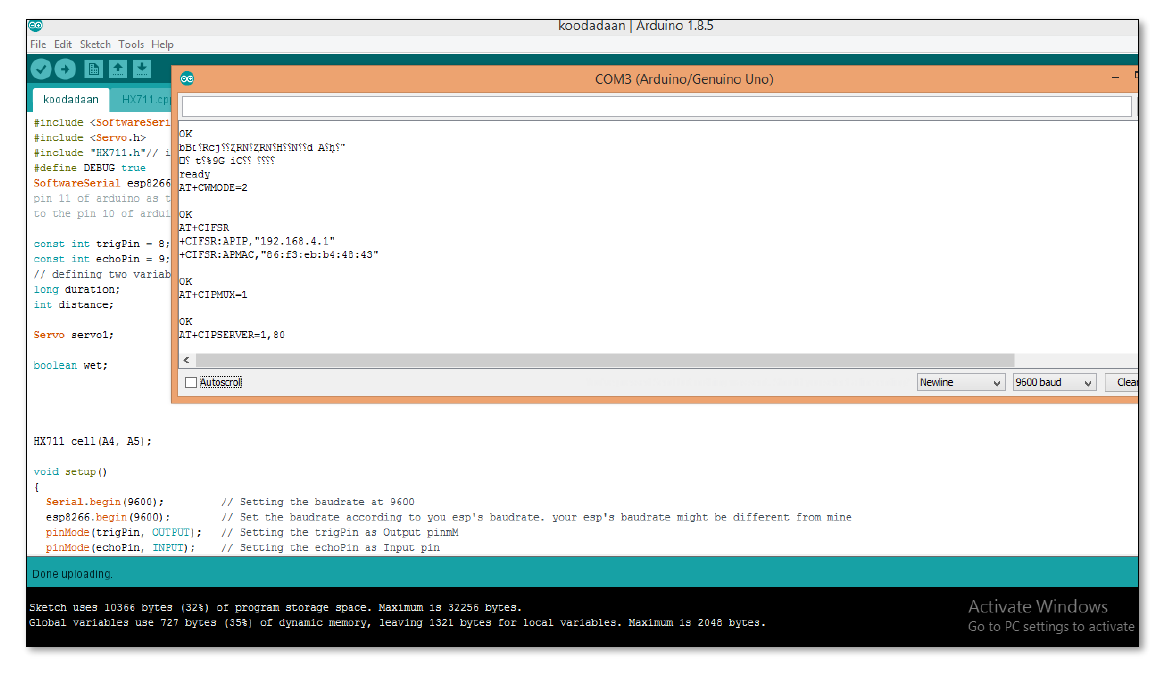
Figure 15. Build-up upon start of the system.